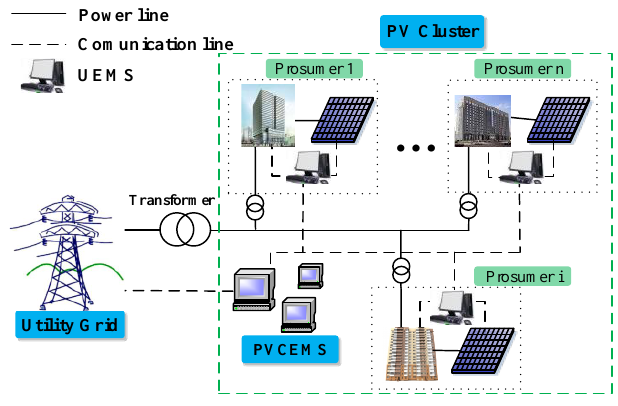
Figure 1. Structure of a PVC.